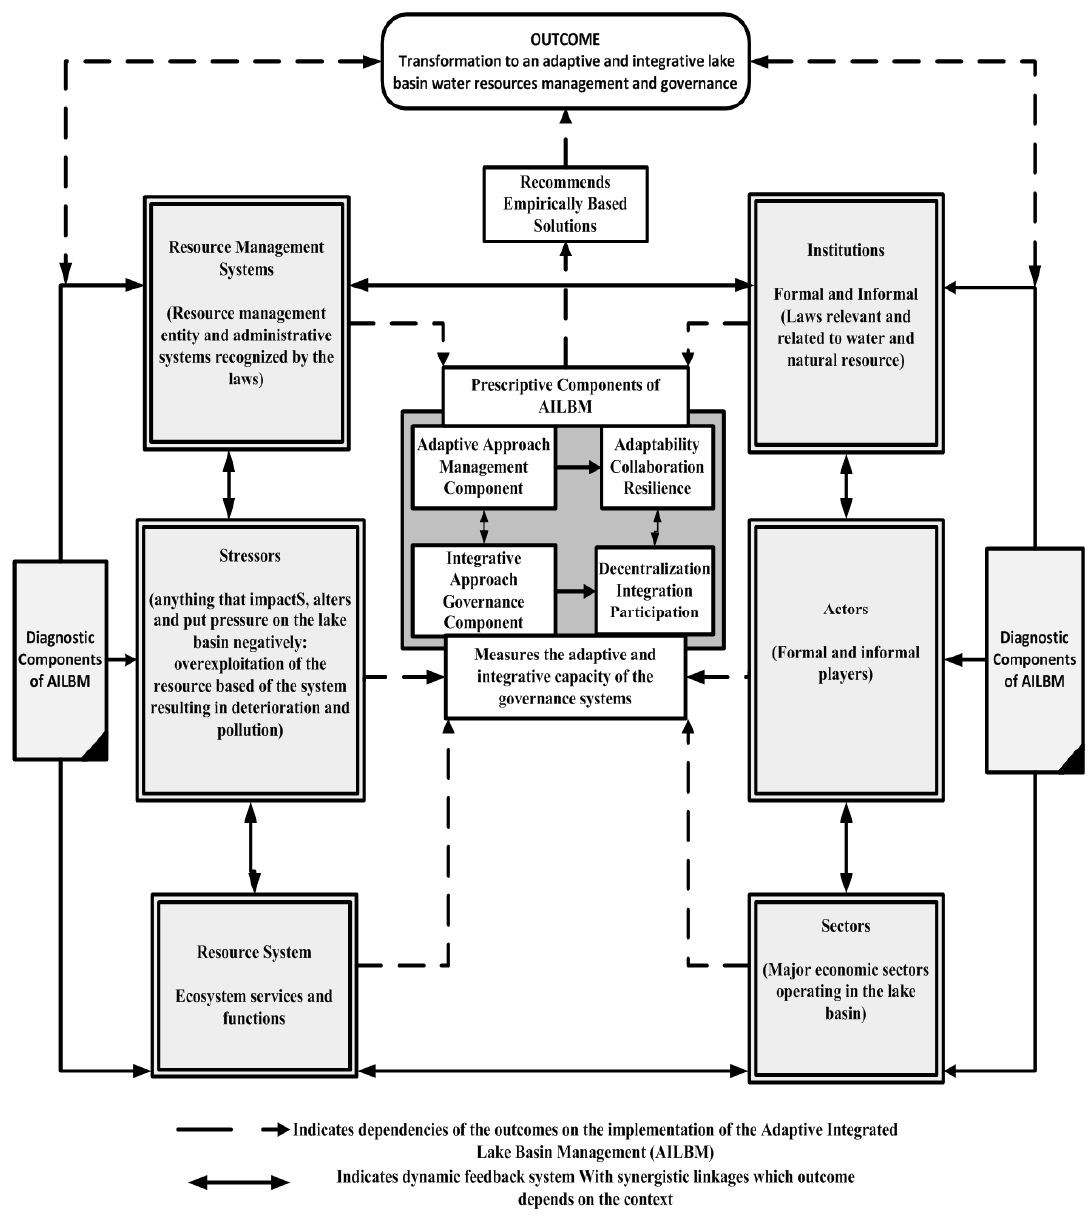
Figure 1. The flowchart of the conceptual framework of the Adaptive Integrated Lake Basin Management (AILBM) for assessment of governance performance of lake basins.